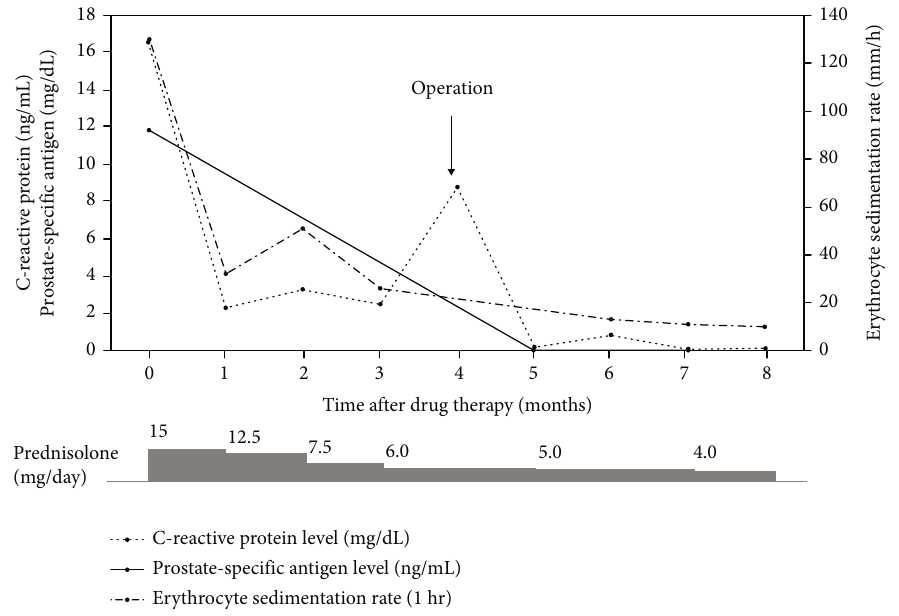
Figure 2: Clinical course and serum levels of an erythrocyte sedimentation rate, a C-reactive protein, and a prostate-speci fi c